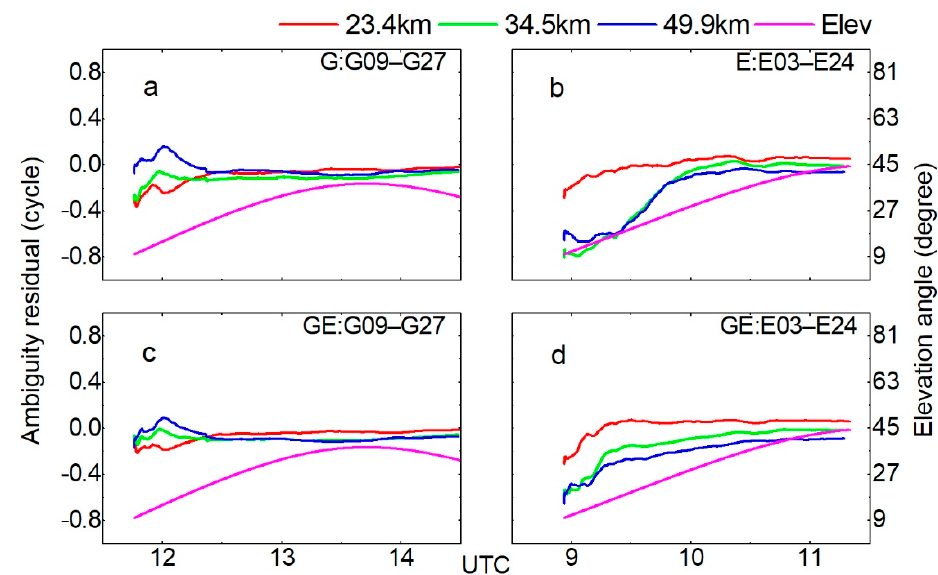
Figure 12. Ambiguity residual of L1 and E1 signal by IF TCAR method in the independent system (upper row) and by CIF TCAR method (lower row) and corresponding satellite elevation angles ( a , c ) are the GPS and GPS + Galileo of G09–G27; ( b , d ) are the Galileo and GPS + Galileo of